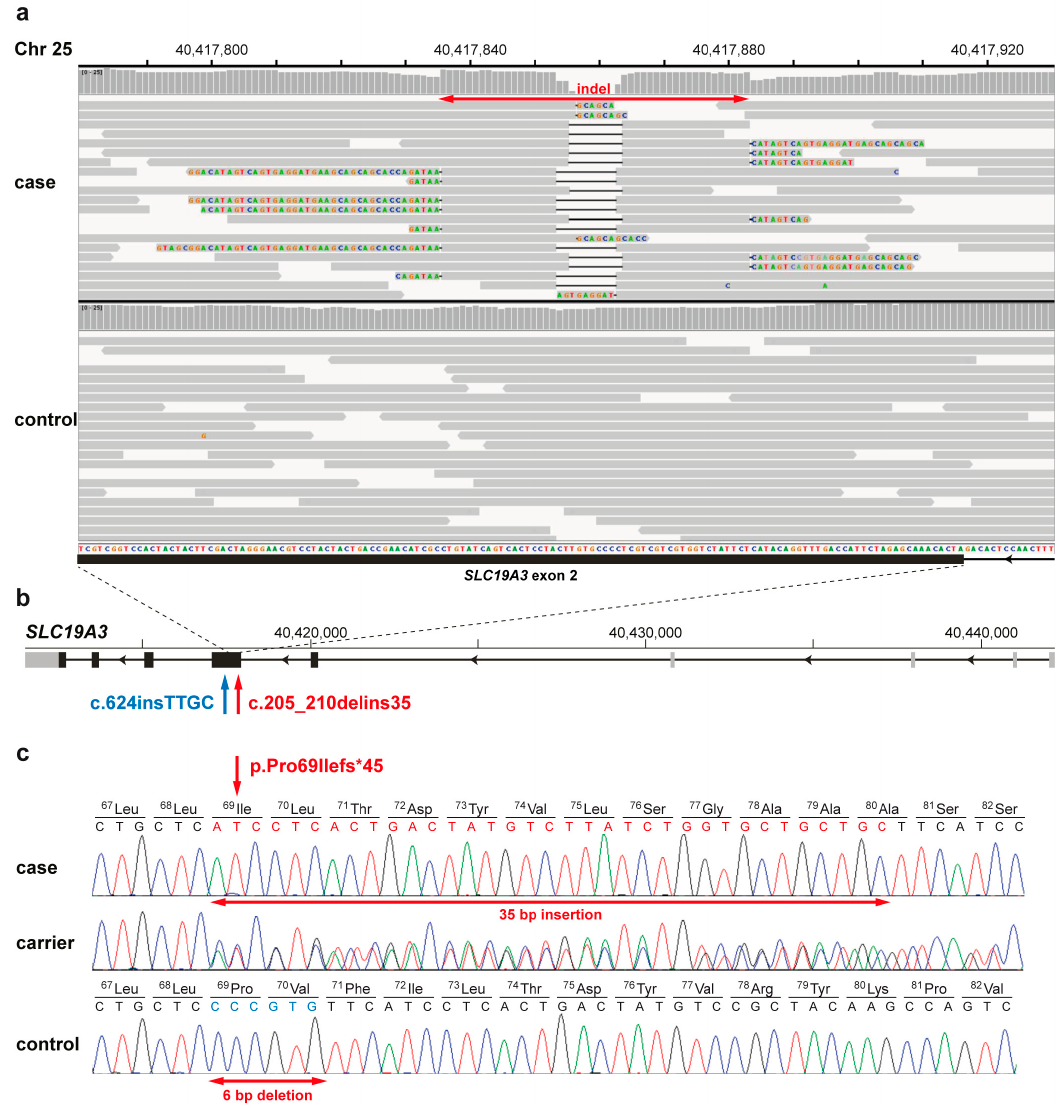
Figure 1. Subacute necrotizing encephalopathy (SNE)-associated SLC19A3 loss-of-function variant in Yorkshire terriers. ( a ) IGV [17] screenshots of the genome region on canine chromosome 25 with the SLC19A3 :c.205_210delins35 variant in an affected and a control Yorkshire terrier (NC_006607.3:40417780-40417930); The indel variant detected in the SNE-affected dog is indicated by a red arrow. ( b ) Schematic representation of the canine SLC19A3 gene showing the location of both pathogenic variants in exon 2 (XM_022409850.1): the herein identified indel (red arrow) and the insertion previously described in encephalopathy-affected Alaskan huskies (blue arrow) [12]. Note that the number of 5 ′ -untranslated exons (grey) varies between transcript isoforms, whereas the five protein-coding 3 ′ -exons (black) are more conserved; ( c ) Sanger sequencing electropherograms illustrate sequences of a homozygous SNE-affected Yorkshire terrier, a heterozygous carrier, and a homozygous wild type dog. The red arrows indicate that the 35 bases shown in red are inserted, whereas the 6 bases in blue are deleted in the mutant allele. The predicted consequence of the shift in the reading frame altering the amino acid sequence of the SLC19A3 protein and leading to a premature stop is shown above.